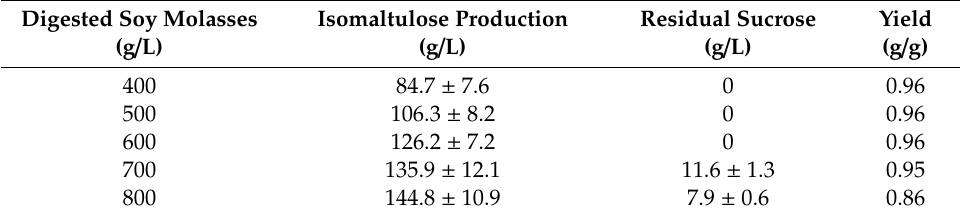
Table 1. Isomaltulose production from soy molasses of di ff erent concentrations.